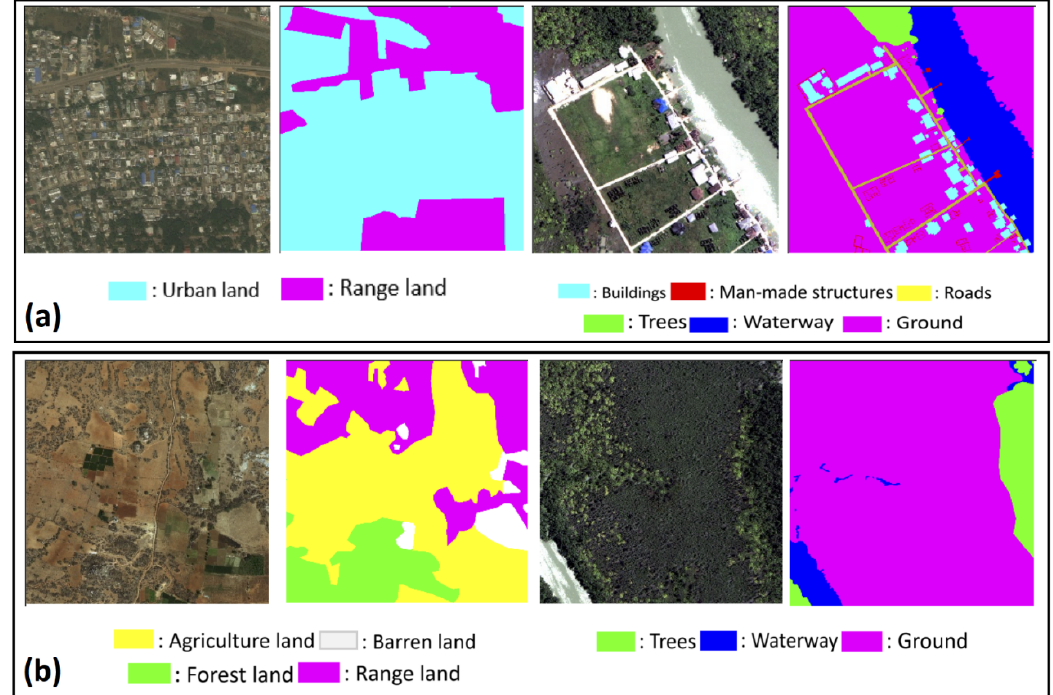
Figure 1. Sample image and label patches from publicly available benchmarks showing inconsistencies of the class definition and level of details, leading to challenges of using them directly as training sets for various RS classification tasks. In ( a ), different benchmark dataset shows different levels of details (Left: A sample patch from DeepGlobe dataset [27]; right: a sample patch from the DSTL dataset [29]) and ( b ) different benchmark dataset shows different class definitions (Left: A sample patch from DeepGlobe dataset [27] with no specific definition of the ground; right: A sample patch from DSTL dataset [29] defines the ground class but include many low vegetations and, inaccurately, some high vegetations).